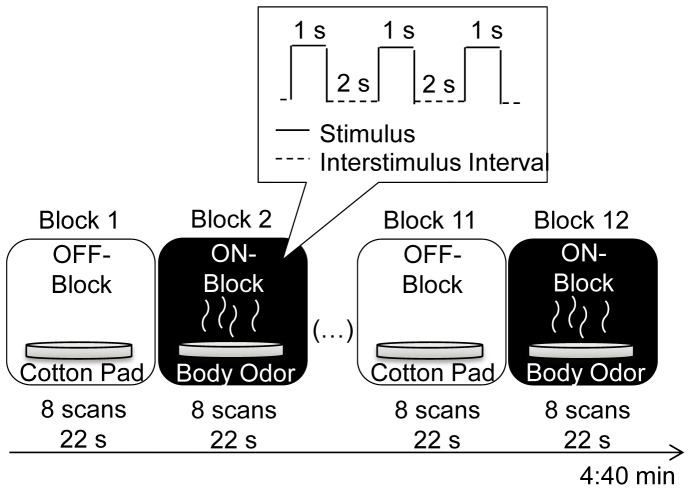
Schematic time course of a scanning session.The participants underwent 4 scanning sessions in succession. Each session consisted of 6 ON-blocks (with presentation of body odor) and 6 OFF-blocks (with presentation of odor-free, pure cotton pad), resulting in a total of 12 blocks. During each block, the stimuli were presented for a period of 1 s with an interstimulus interval of 2 s. Each block had a duration of 22 s, during which 8 scans were conducted.